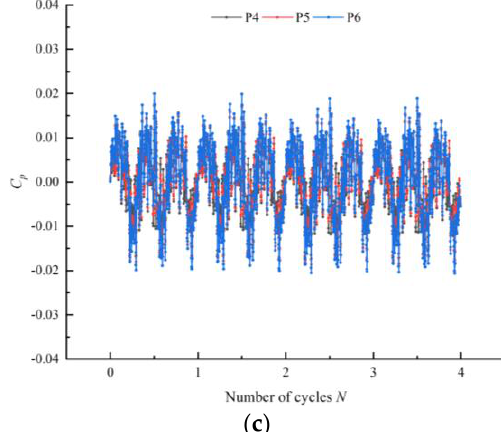
Figure 17. Time domain diagram of C p at impeller outlet: ( a ) Q = 0.8 Q bep ; ( b ) Q = 1.0 Q bep ; ( c ) Q = 1.2 Q bep .